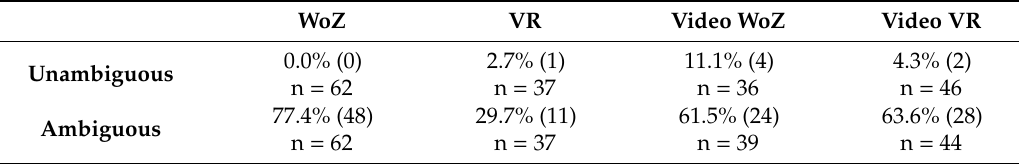
Table 2. Misinterpretations of the intention Let the HRU go first .